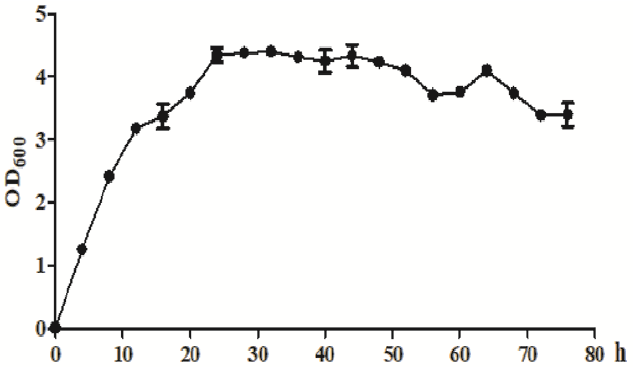
Figure 4. The growth curve of Klebsiella sp. O852 (cultivation conditions were at 30 °C and 150 rpm).